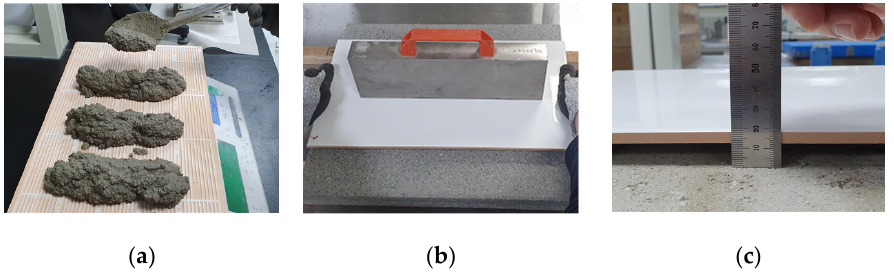
Figure 11. Specimen preparation method: ( a ) mortar setting for spot-bonding; ( b ) 100 N weight placement; ( c ) mortar thickness measurement.